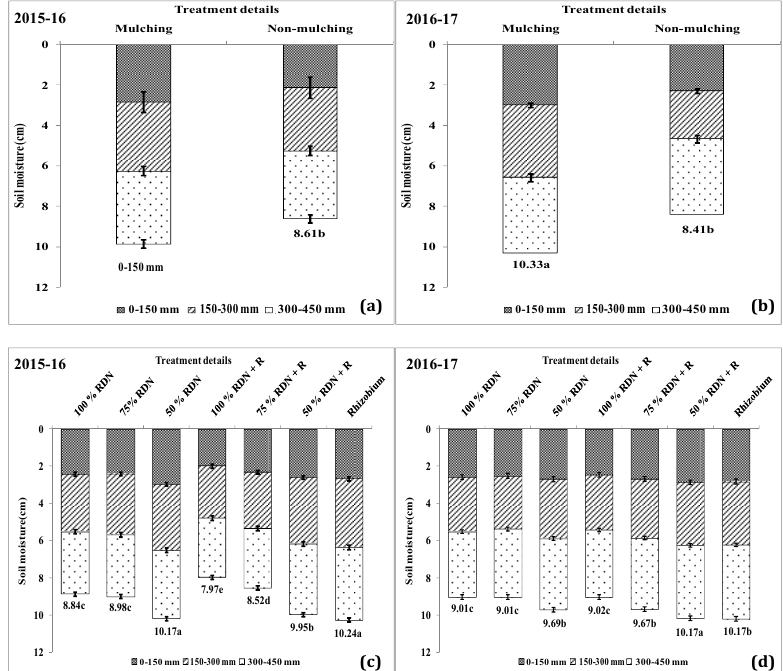
Figure 7. Effect of mulch ( a , b ) and nutrient dose ( c , d ) on root zone moisture storage (cm) at pod formation of peanut(data from 2015–2016 and 2016–2017 crop seasons, respectively); within treatments, numbers followed by different letters indicate significant differences at p ≤ 0.05 (otherwise statistically at par); error bars represent the least significant difference value.